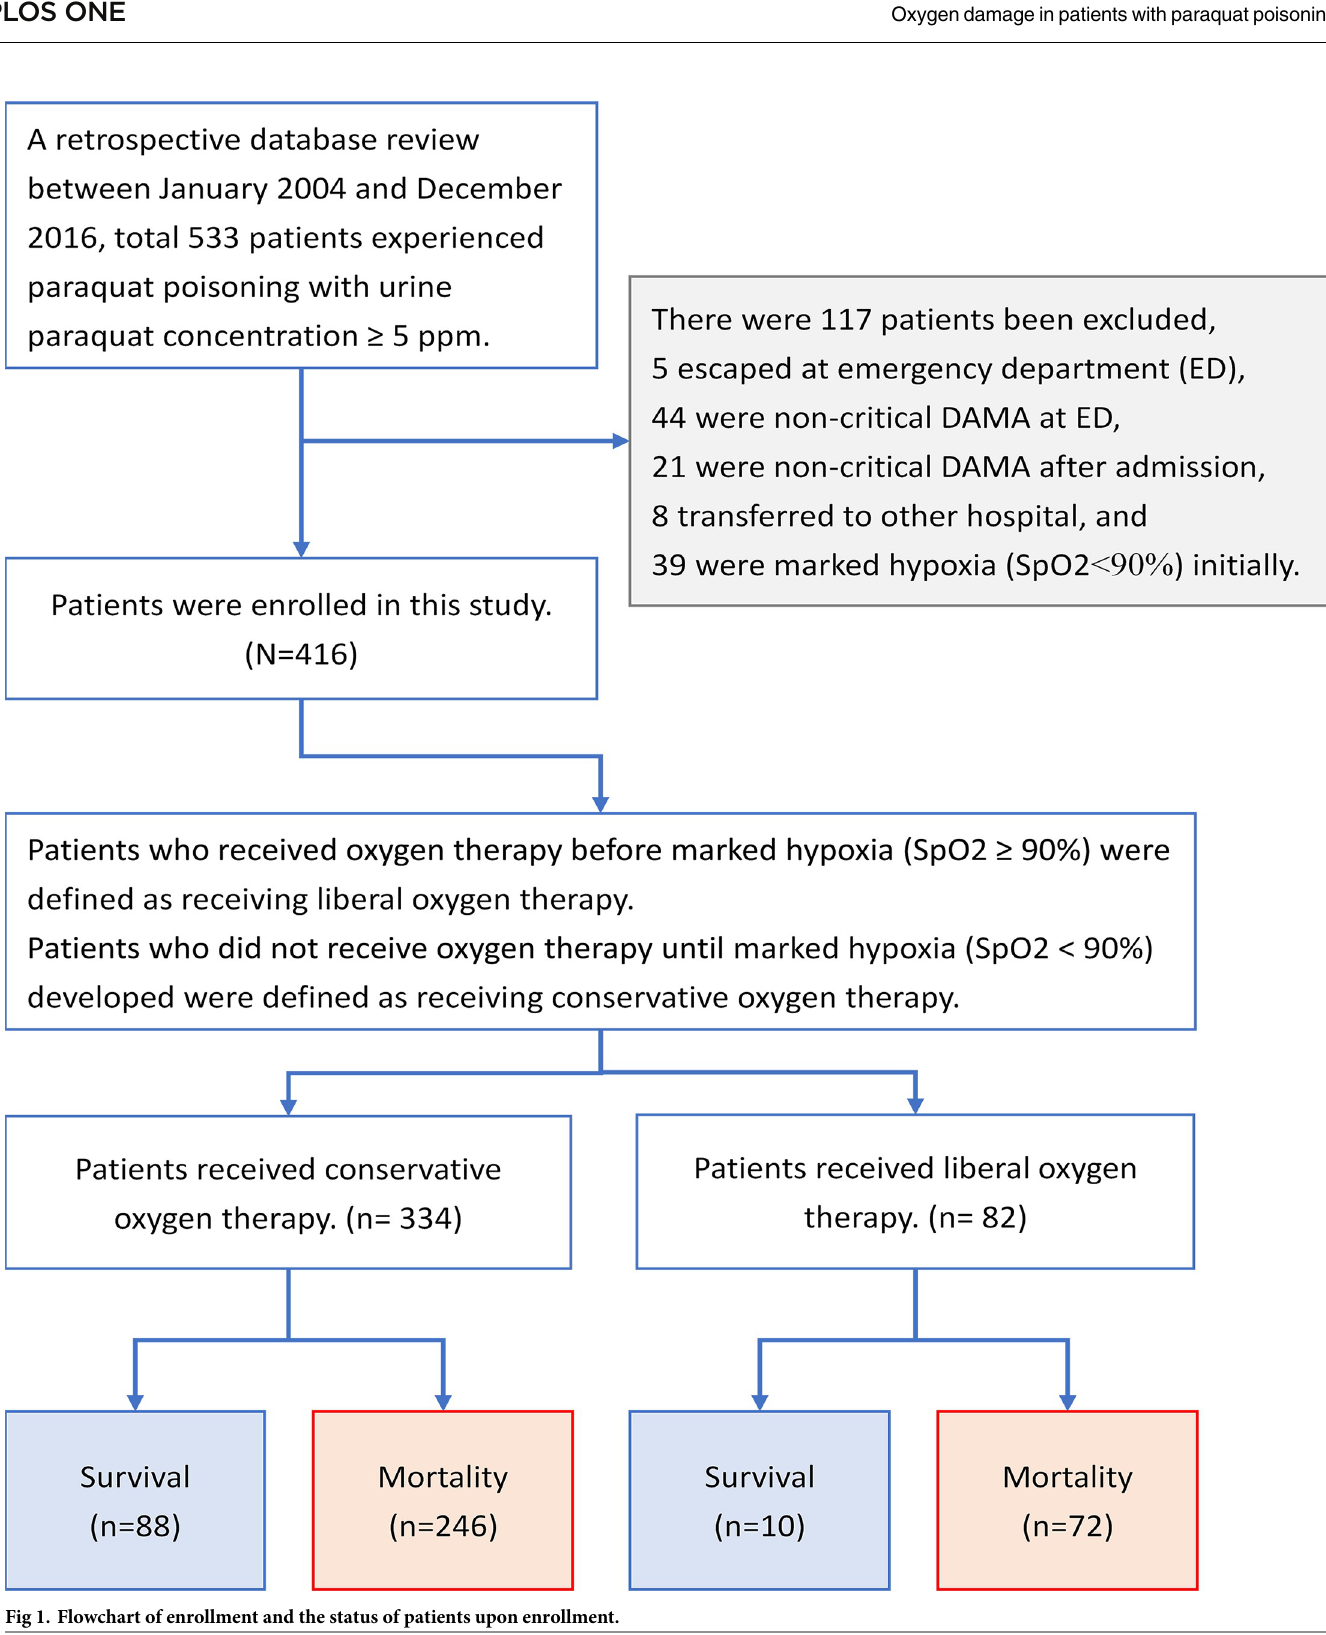
PLOS ONE | https://doi.org/10.1371/journal.pone.0245363 January 15,